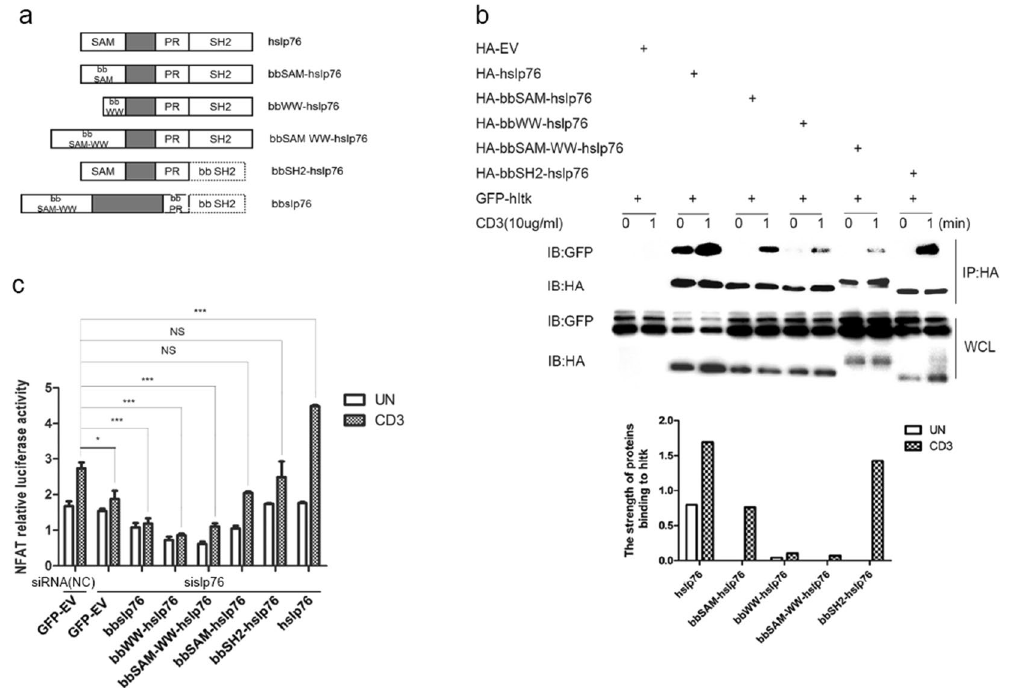
Figure 5. Mapping bbslp76 inhibition domain. ( a ) Schematic structures of chimeric proteins. ( b ) Interactions of chimeric proteins with hItk. Jurkat TAg cells were transfected with the indicated constructs. After 48 hrs, cells were stimulated with or without CD3 (10 μ g/mL, 1 min) and then lysed; lysates were split into two